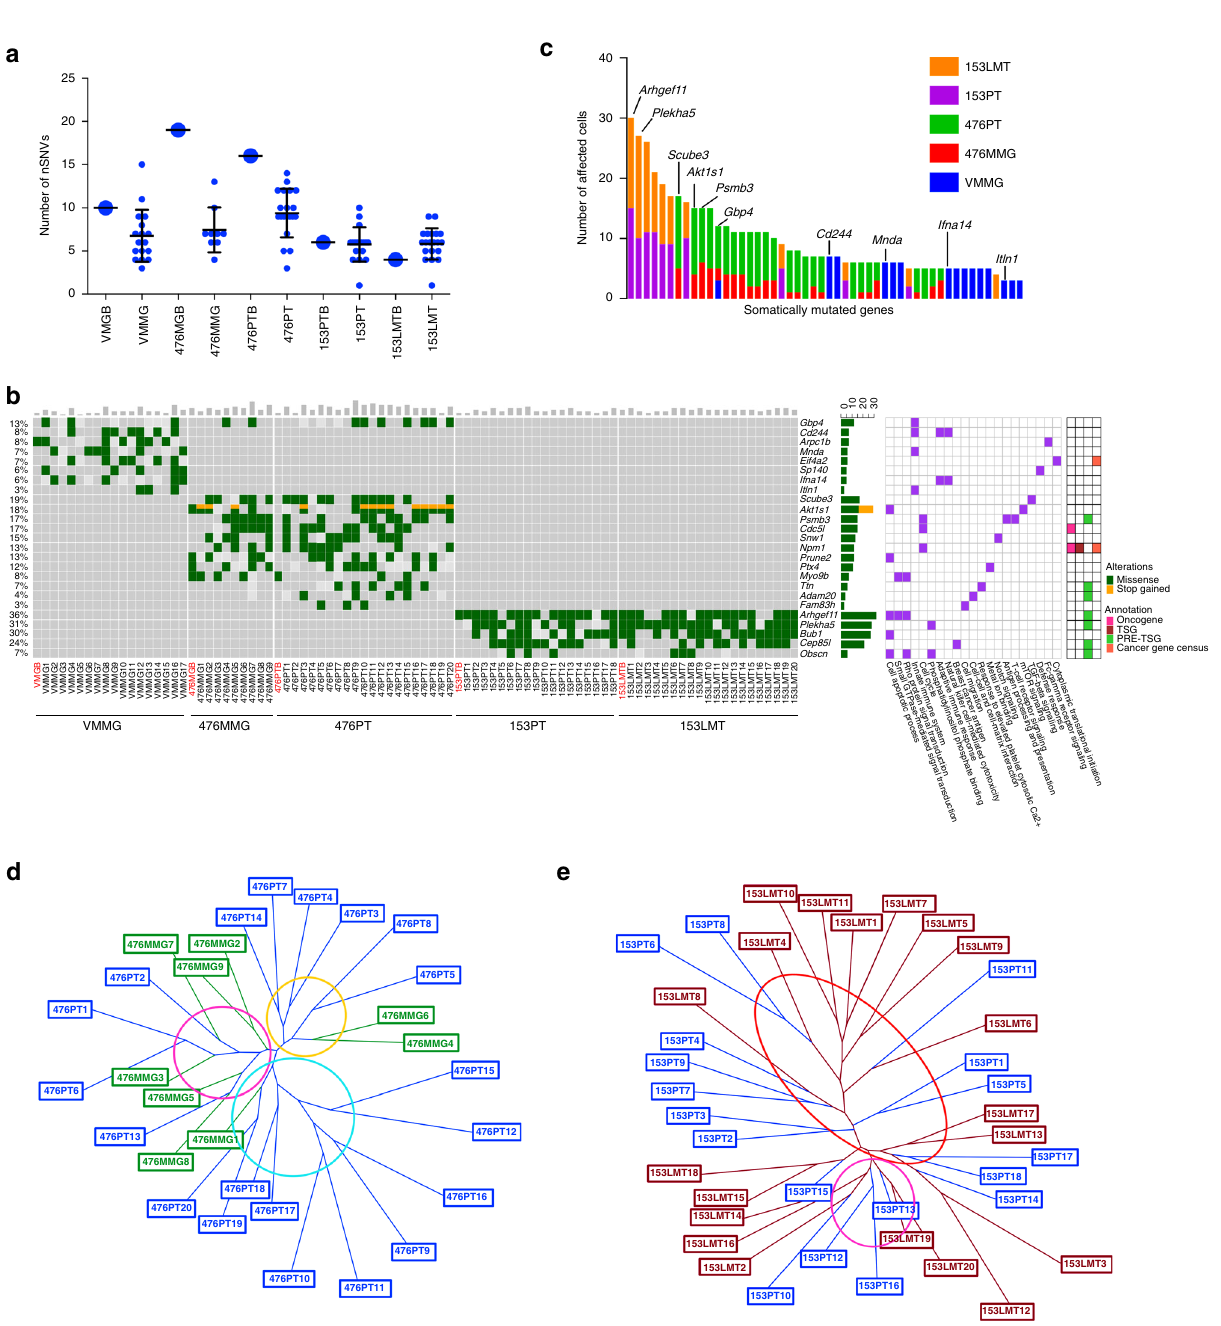
Fig. 4 Driver mutations and clonality of Brca1 -de fi cient breast tumors revealed by scWES. a Number of nonsynonymous SNVs of human homologous genes in single cells and paired bulk samples from different tumor developmental stages. A big dot indicates a bulk sample, a small dot indicates a single cell (VMGB, n = 1 bulk tissue; VMMG, n = 17 cells; 476MGB, n = 1 bulk tissue; 476MMG, n = 9 cells; 476PTB, n = 1 bulk tissue; 476PT, n = 20 cells; 153PTB, n = 1 bulk tissue; 153PT, n = 18 cells; 153LMTB, n = 1 bulk tissue; 153LMT, n = 20 cells. Error bars represent SD). b Oncoplot summarizing recurrently altered genes in single cells and paired bulk samples according to the developmental stages. A gray rectangle indicates the wild-type status of the indicated site, a light gray rectangle indicates no coverage of the indicated site. c Incidence plot of frequently mutated genes ( ≥ 3 affected cells) detected in the series ( n = 50 genes; n = 84 cells). d The neighbor-joining phylogenetic tree showing the clonality of 476MG and 476PT. The subclones were circled and determined by at least more than four cells distributed in a trunk. e The neighbor-joining phylogenetic tree showing the clonality of 153PT and 153LMT. The subclones were circled and determined by at least more than four cells distributed in a